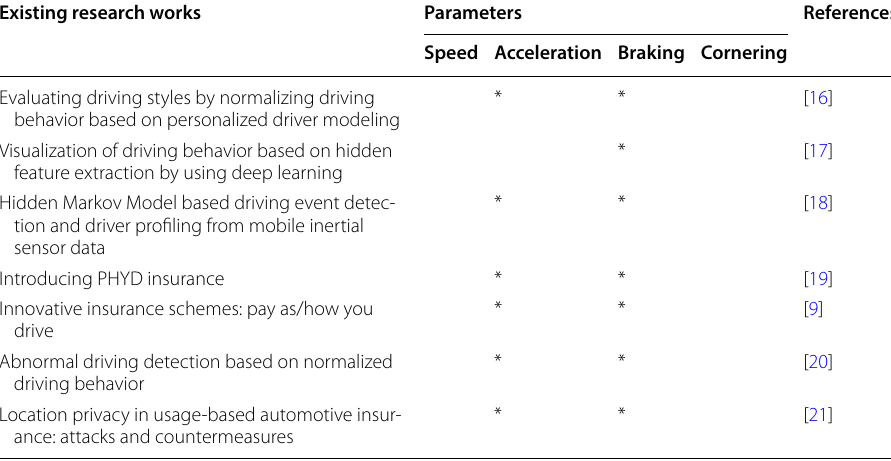
Table 2 Parameters used in research papers Existing research works Parameters Speed Acceleration Braking Cornering